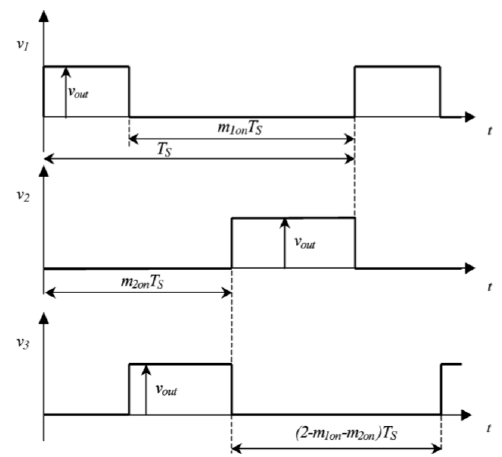
Figure 2. Relationships among v 1 , v 2 and v 3 voltages and switch on-duty